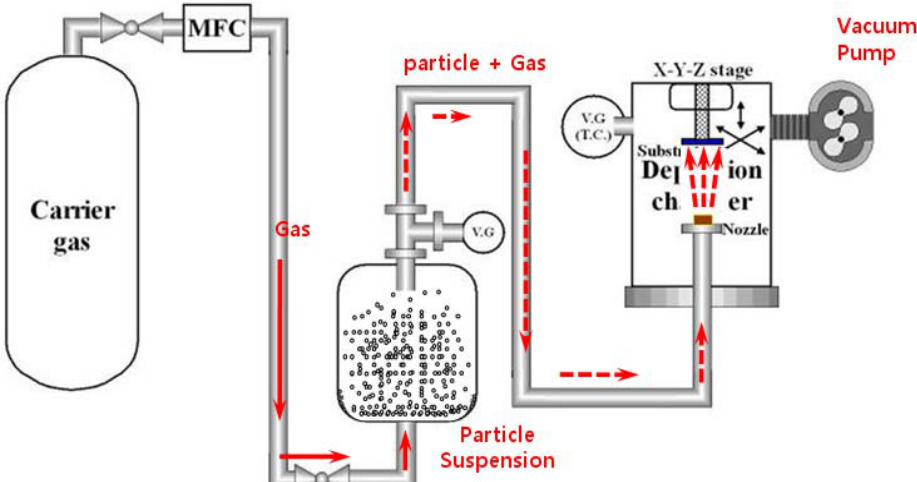
Figure 9. Schematic diagram of an aerosol deposition (AD)